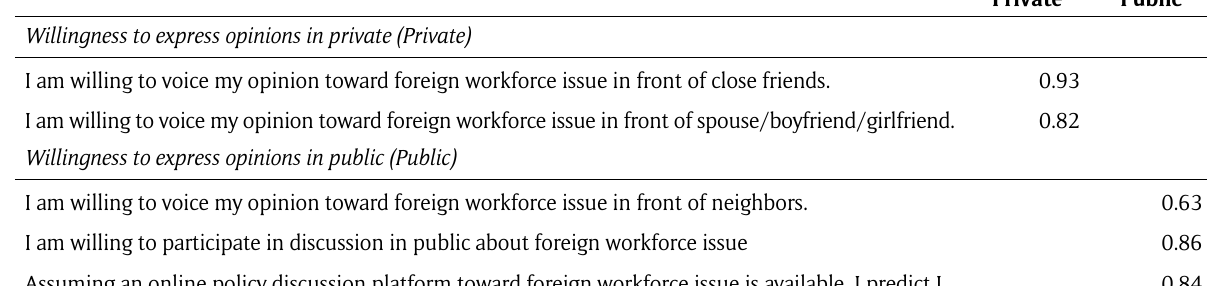
Table 2: Factor analysis results of willingness items